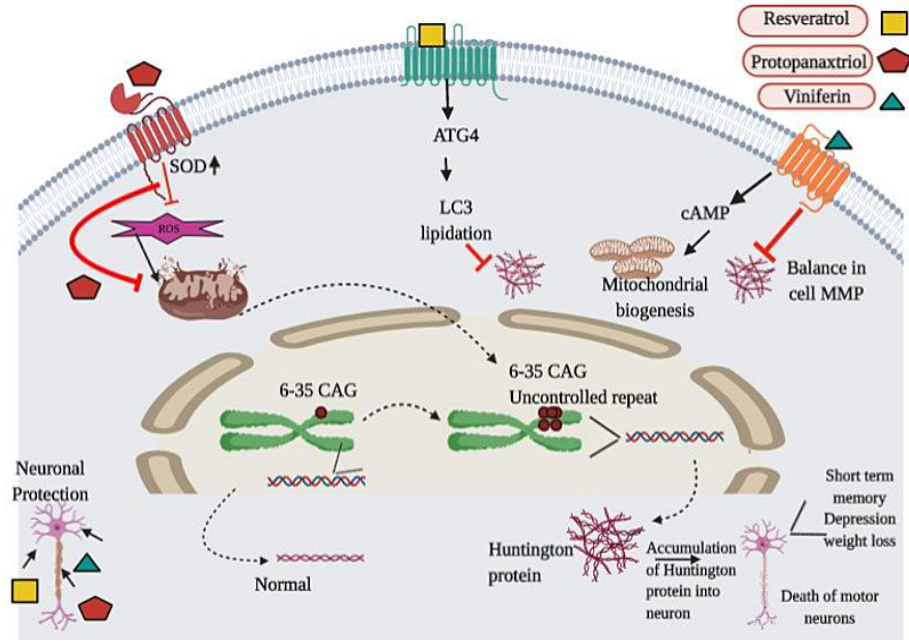
Figure 5. Diagrammatic presentation of Huntington Disease progression and protection of neurons with phytochemicals: 6-35 CAG repeats lead to the formation of Huntingtin protein which consequently accumulates in the neurons and damage motor neurons. In the early stage, damaged motor neurons result in short term memory while on a later stage, this condition changes into depression, weight loss, and many more. The studied phytochemicals generally work against free radicals and restrict the accumulation of Huntingtin protein in the cells. This inhibition further leads to neuronal survival. Resveratrol works on LC3 lipidation while protopanaxtriol and viniferin leads to the antioxidative pathway and restore the function of mitochondria to protect the neurons and stop further accumulation of Huntingtin protein in